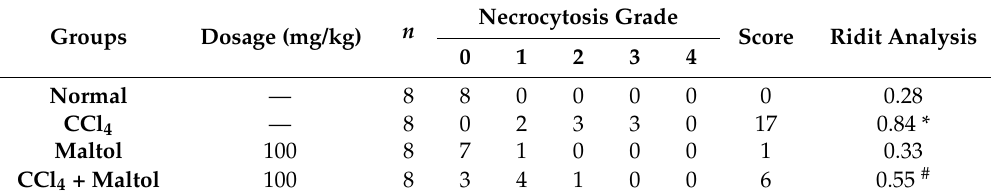
Figure 2. Histological examination of morphological changes in liver tissues of hematoxylin–eosin (H&E) staining. The pale pink area shows the necrotic area. Original magnification: 100× and 400×. Table 2. Pathological changes in the liver and Ridit analysis.